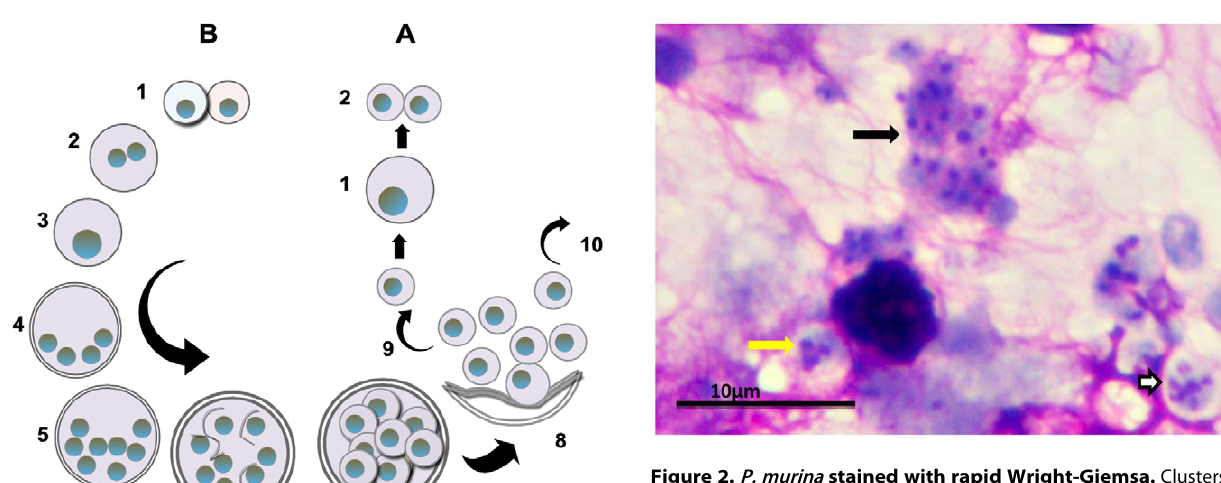
Figure 2. P.murina stained with rapid Wright-Giemsa. Clusters of P. murina from a homogenate of an infected mouse lung were dropped on glass slides and stained with a rapid Wright-Giemsa. The black arrow points to a cluster of trophic forms. The white arrow indicates a mature cyst. The yellow arrow indicates an immature cyst with only three nuclei present in this section. The magnification bar represents 10 um. The micrograph was taken with an Olympus BH2 microscope and DP-72 digital